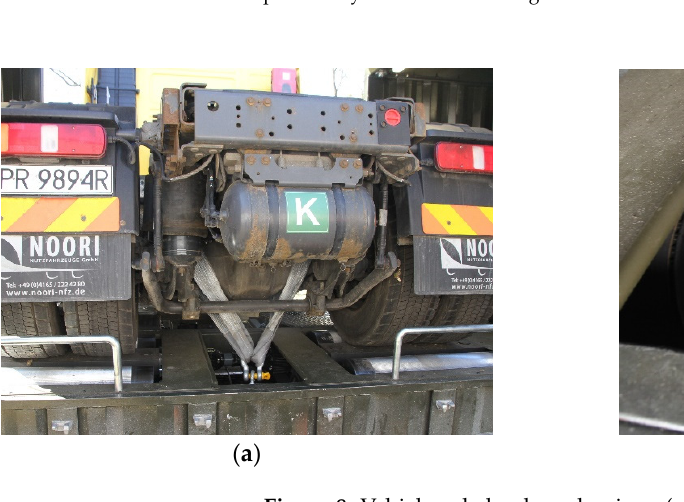
Figure 8. Vehicle axle load mechanism: ( a ) general view, drive axle slings, ( b ) view of rope linked with an electric winch (authors’ source).